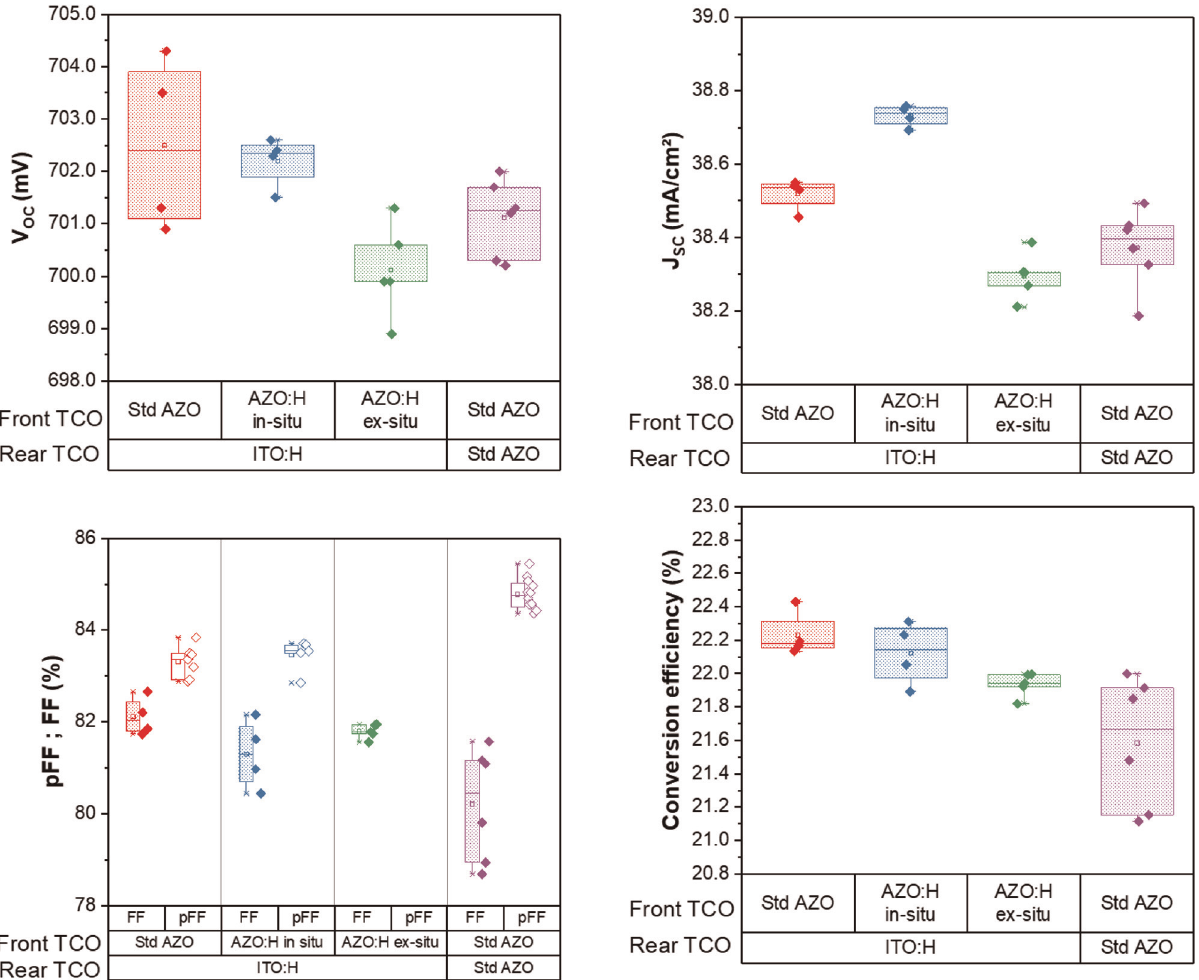
Fig. 10. Cell parameters obtained (V OC , J SC , FF and conversion ef fi ciency) for different structure of solar cells fabricated. Table 1. Summary of cell performances obtained for solar cell